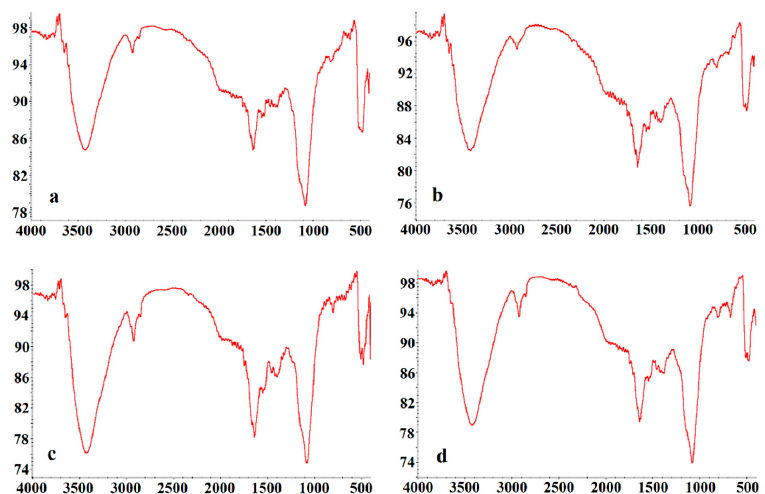
Figure 4. Infrared spectra of LVPs extracted by different methods. ( a ) LVP-u; ( b ) LVP-m; ( c ) LVP-e; ( d ) LVP-h.